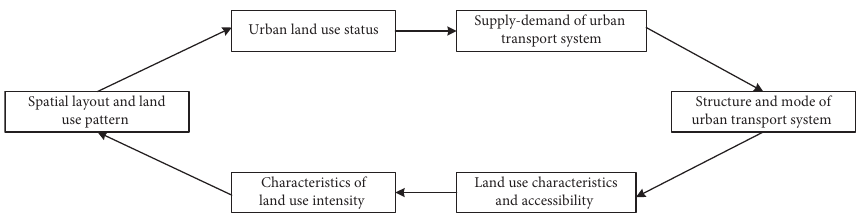
Figure 2: Influence mechanism between spatial layout, land use, and transport